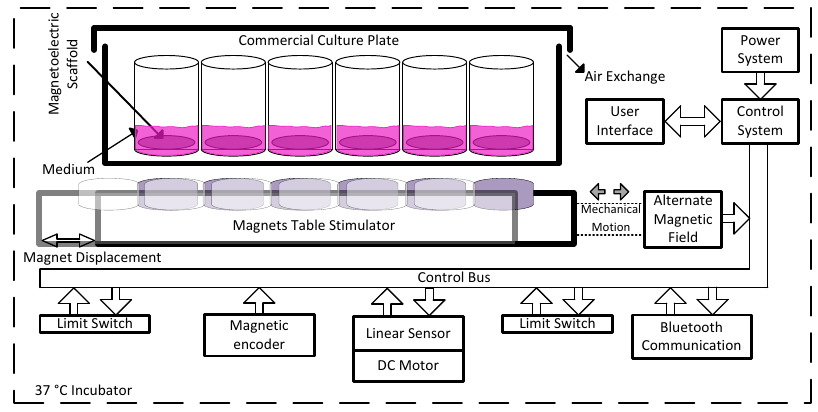
Figure 1. Magnetoelectric bioreactor operating principle through the use of electrical and mechanical controls to produce an alternated magnetic field and thus stimulate the magnetoelectric scaffolds and, consequently, the cells.